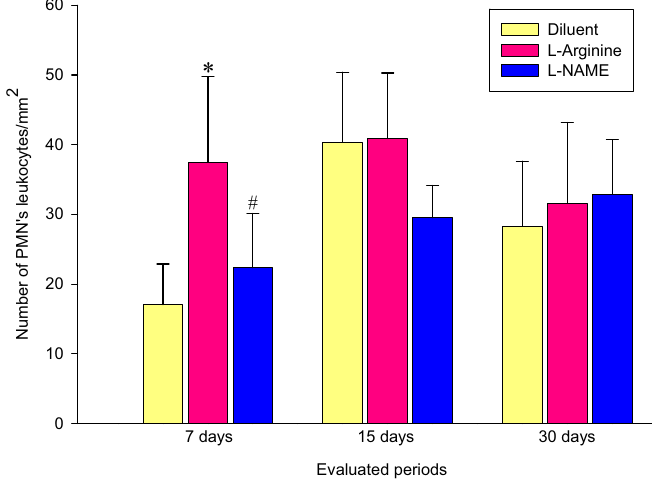
FIGURE 4 - Influence of L-Arginine and L-NAME treatments on PMN’s leukocytes influx during tumor growth.